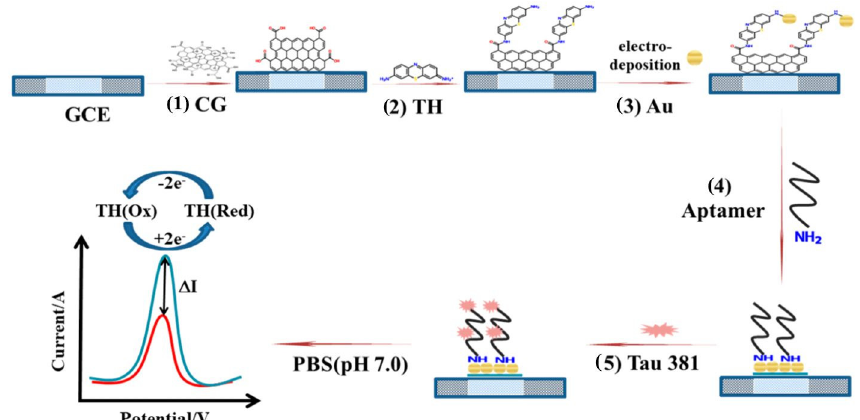
Figure 4. Schematic representation of tau-381 detection with the aptamer-based biosensor: (1) Doped CG on a GCE surface. (2) The incubation with Thi. (3) Electrodeposition and reduction of HAuCl 4 ·3H 2 O to AuNPs. (4) Immobilization of aptamer. (5) The detection of tau-381 levels in HS by using DPV technique. Reprinted with permission from Ref. [136].